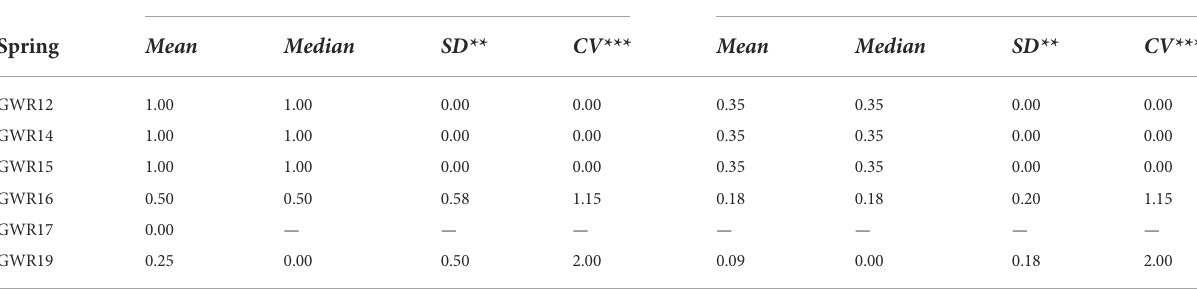
TABLE 4 Probability of infection/year and probability of illness for adults and children due to the consumption of water contaminated with pathogenic E. coli. Probability of infection/year*